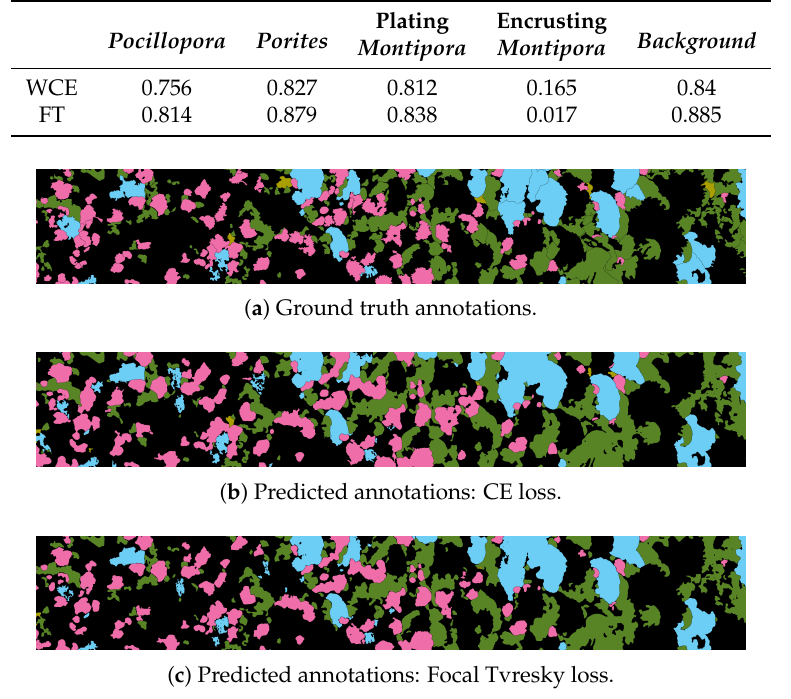
Figure 6. Automatic labeling generated from models minimizing different loss functions. Compared with GT ( a ), the model minimizing CE ( b ) outputs smother and larger regions. The use of